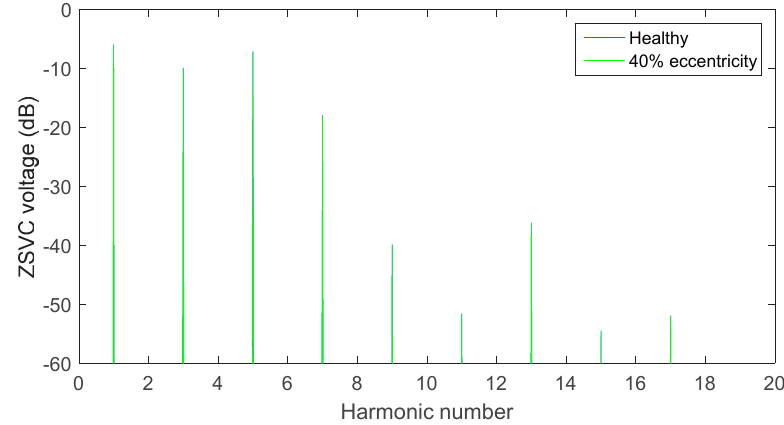
Figure 8. Low-current low-saturation operating conditions. Spectral content of the ZSVC. Healthy machine and faulty machine with 40% eccentricity.